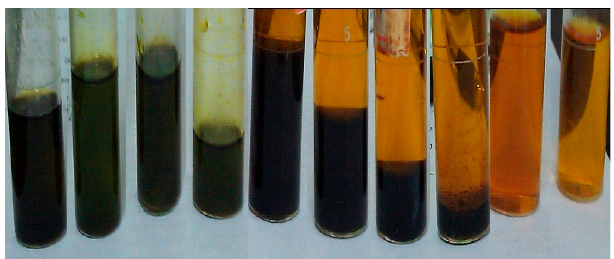
Figure 1. Effect of water volume percents on the formation of [bmim]Fe(III)Cl 4 –H 2 O mixtures. x (H 2 O) from left to right are: 5.88%, 10%, 20%, 30%, 40%, 50%, 60%, 70%, 80%, and 90%.